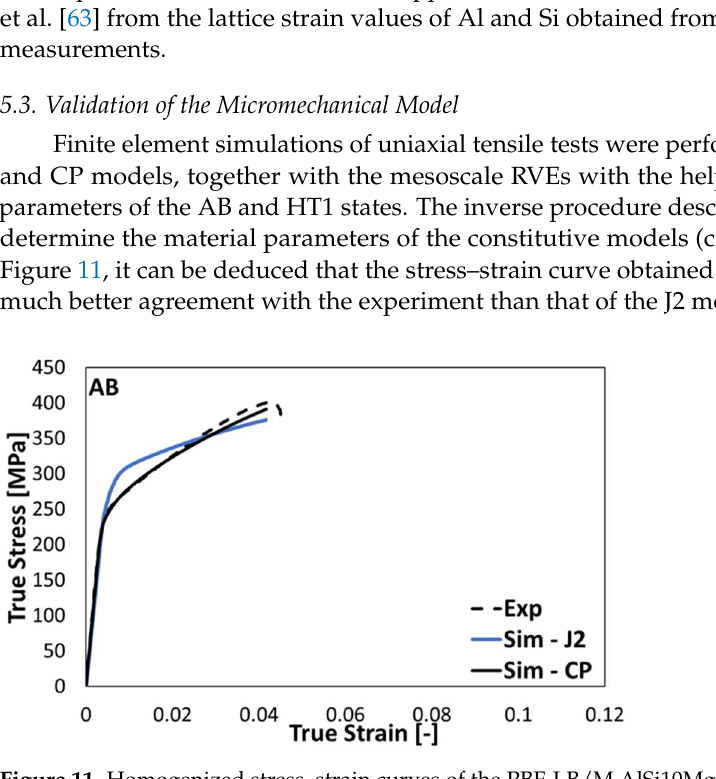
Figure 11. Homogenized stress–strain curves of the PBF-LB/M AlSi10Mg AB state obtained from the J2 and CP models. J2 and CP